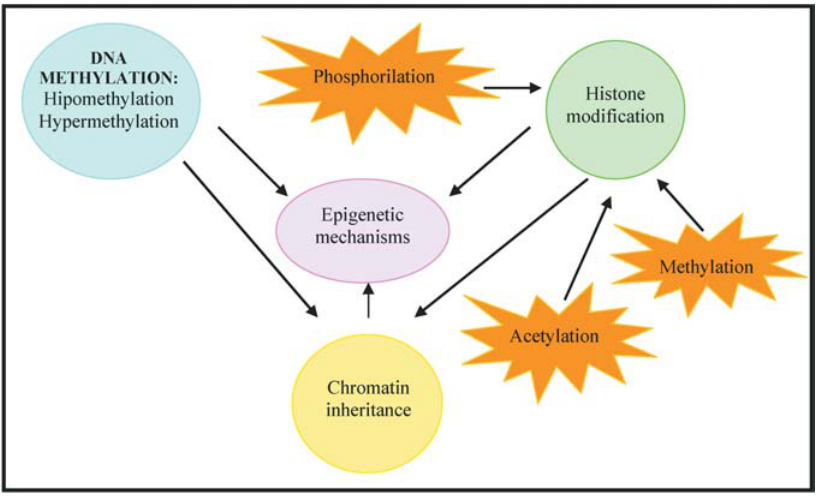
Fig. 5 – Epigenetic mechanisms involved in chemical carcinogenesis.